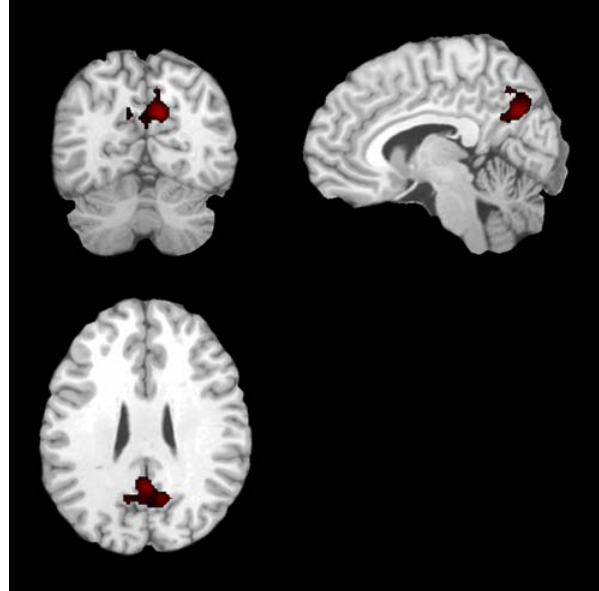
Figure 1. Posteromedical cortex (PMC), denoted in red and overlaid on a canonical T1-weighted brain template image in three orthogonal views, was used as an apriori functional region of interest. In this region parameter estimates for activation magnitude showed a lesser-to-greater activation from Control, to MCI, to AD